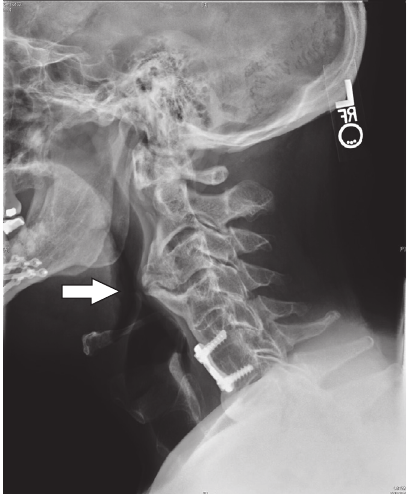
Figure 1: Large anterior osteophytes involving C2–4 (white arrow). Note there is sparing of the disc spaces. The bulge narrows the upper airway, abutting the